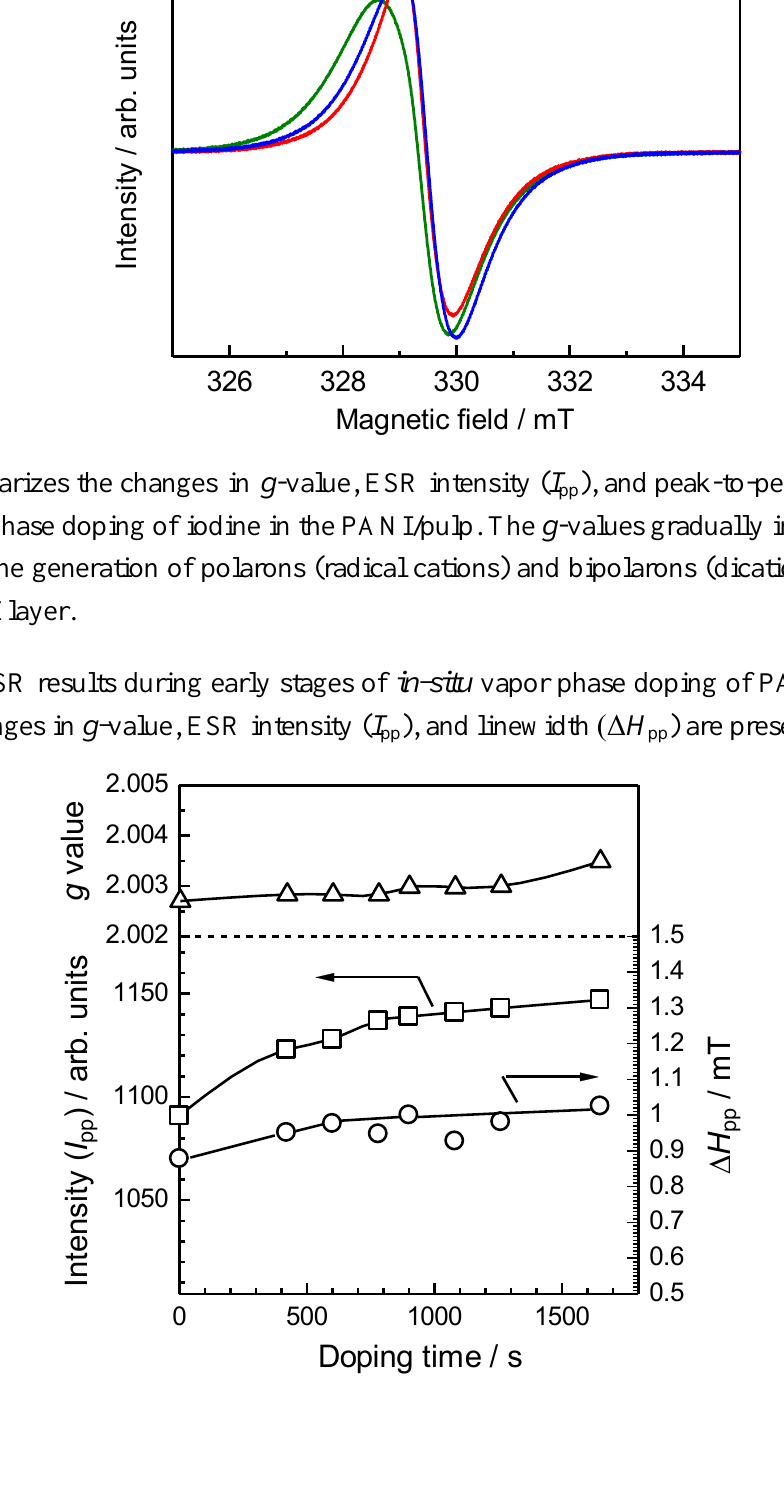
Figure 3. In-situ ESR spectra of PANI/pulp during vapor-phase doping of iodine. (Red) pristine PANI/pulp (emeraldine base (EB), no iodine doping), (blue) doping time = 1,260 s, (green) doping time = 10,260 s (171 min).